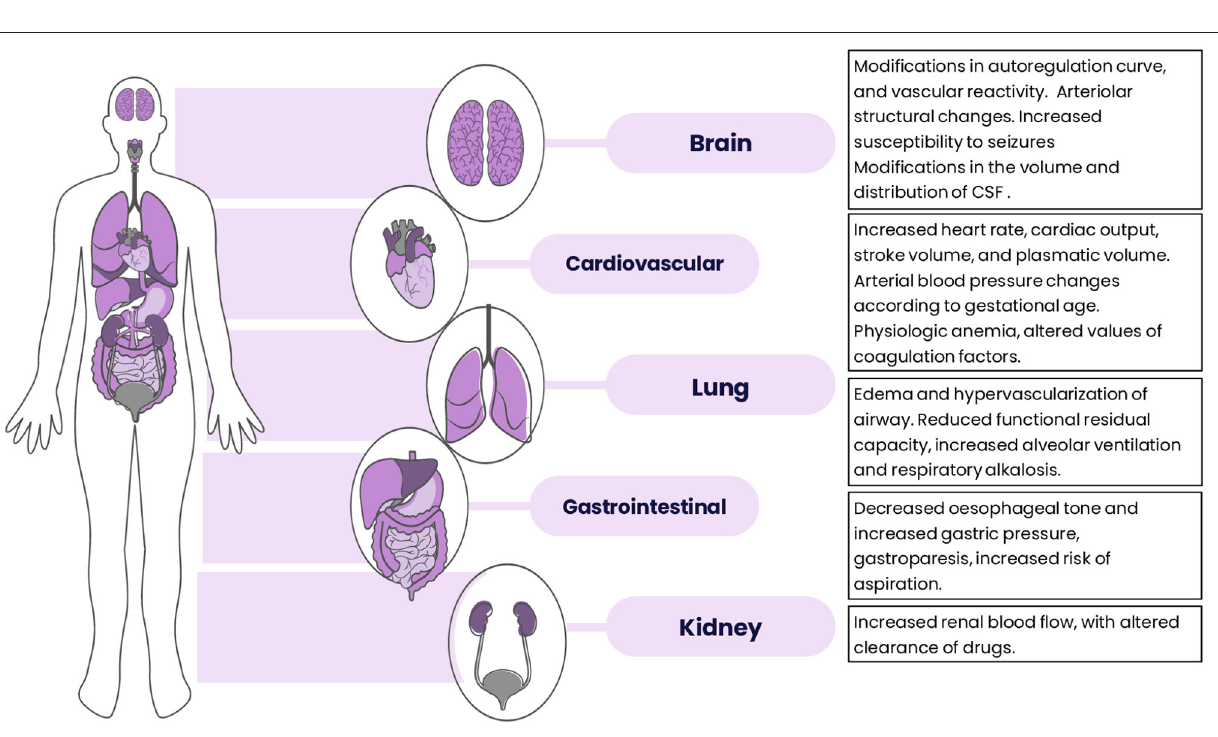
FIGURE 2 | Pathophysiological changes that occur during pregnancy. CSF, cerebrospinal